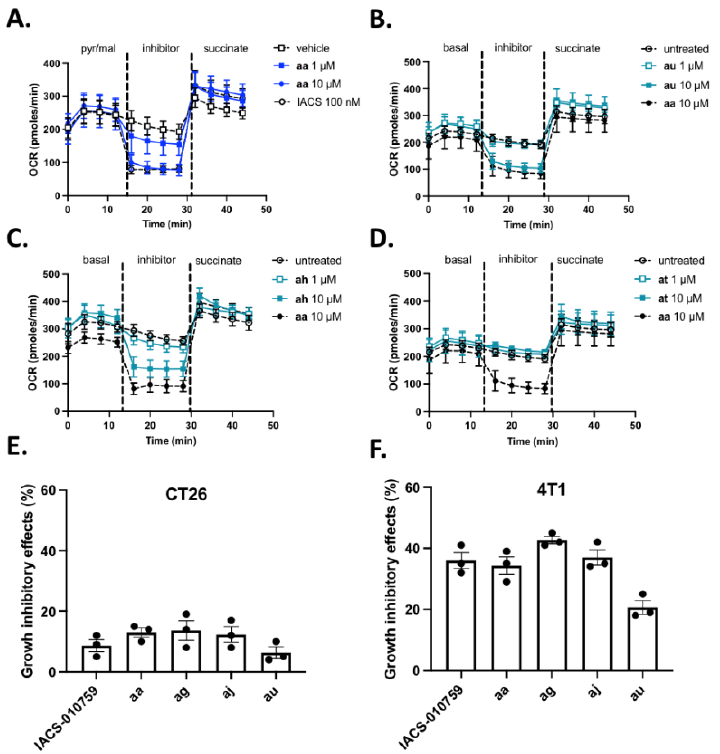
Figure 4. Mitochondrial complex I activity inhibition (Assay #2). ( A – D ) . Graphs depict changes in O 2 consumption rate (OCR) measured with the Seahorse technology on permeabilized CT26 cancer cells upon successive addition of pyruvate/malate, the indicated inhibitor and succinate. OXPHOS I inhibitor IACS was used as a control in the experiments testing reference compound aa ( A ), and compound aa (10µM) was used as reference for testing au, ah and at derivatives ( B – D ) (n = 6 per compound). ( E , F ) . Growth inhibitory effects of cultured CT26 ( E ) and 4T1 ( B ) cancer cells exposed to 100 nM IACS or 1 µM aa, ag, aj and au compounds for 72 h; data represent the reduced extent (expressed as %) of cell viability (determined with Presto Blue) when compared with vehicle conditions (n = 3).